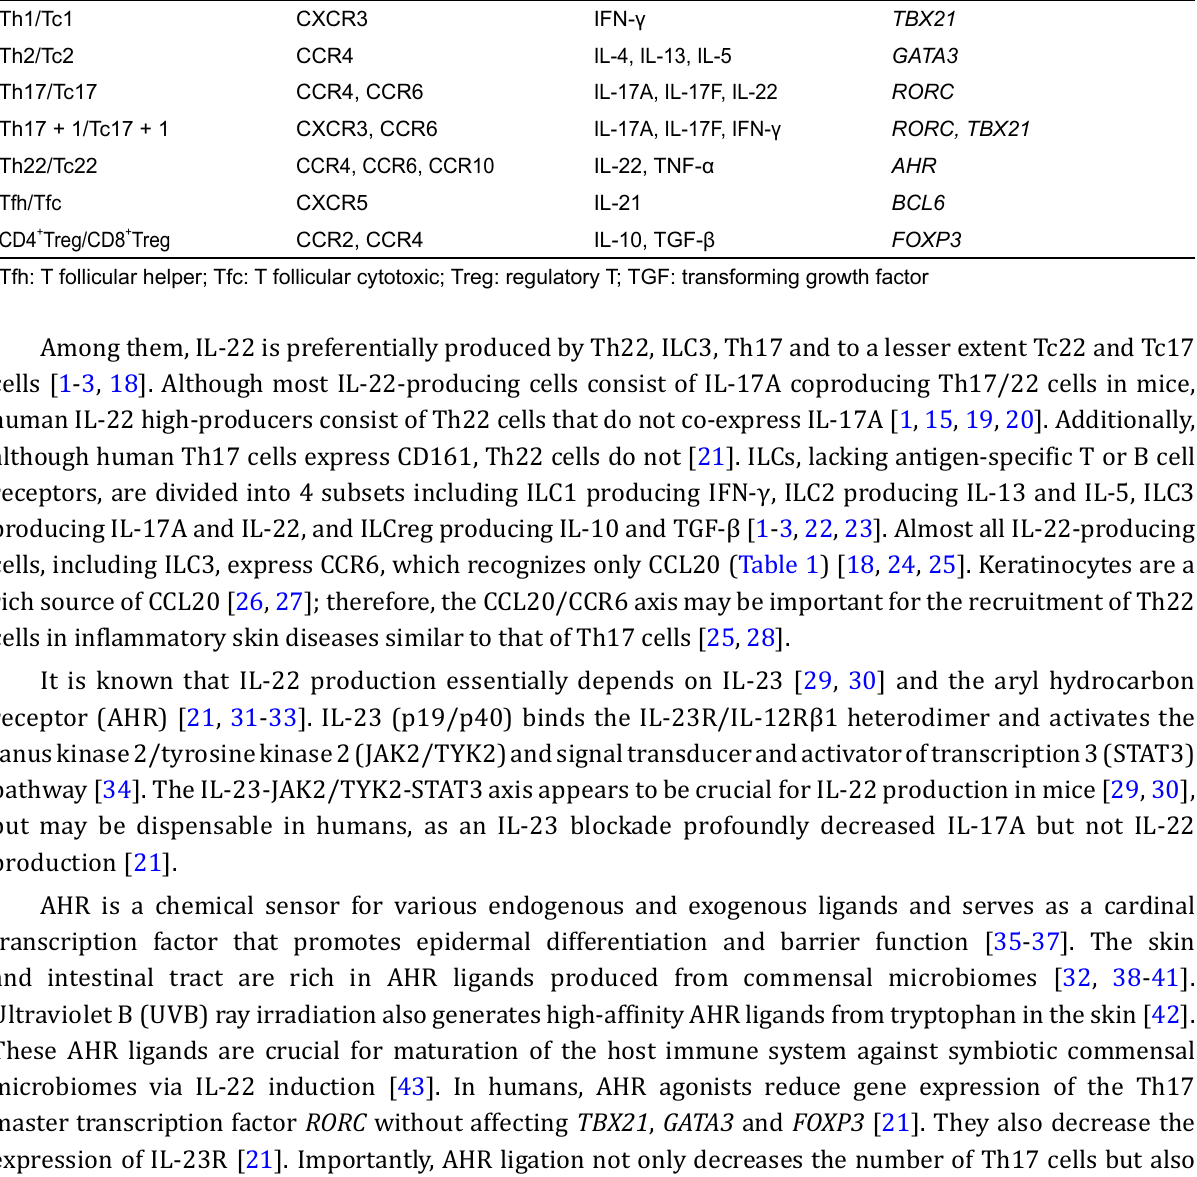
Table 1. T cell subsets T cell subsets Surface markers Cytokine production